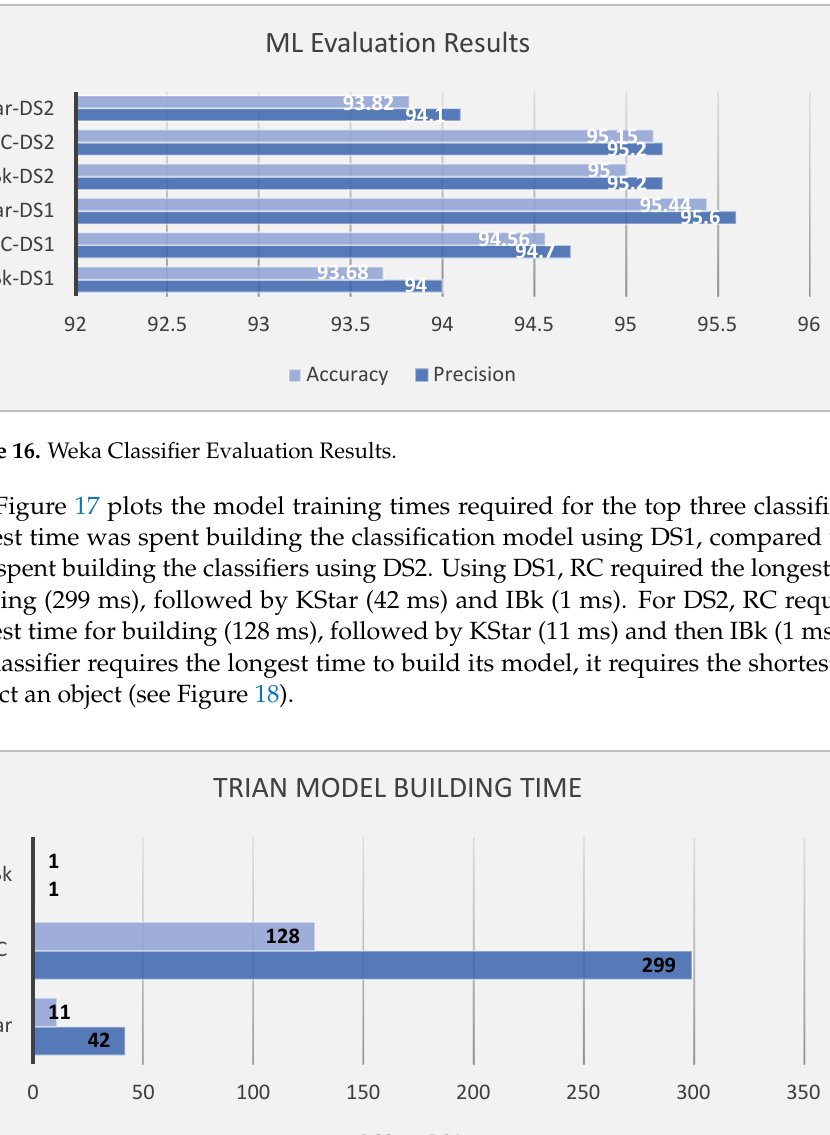
DS1 and DS2 test samples, we constructed 10 test predictions and timed each classifier in order to produce the outcome. The time required for KStar to forecast an object varied between 22 and 55 milliseconds when using the DS1 test samples and between 9 and 13 milliseconds when using the DS2 test samples. The IBk classifier, on the other hand, showed faster times than KStar, with an average of 4–5 milliseconds for the DS1 test sam- ples and 0–1 milliseconds for the DS2 test samples. Random Committee required a sub- stantial amount of time to develop its training model, and it predicted the test samples in less than 1 millisecond for both the DS1 and DS2 test samples. ( a ) ( b ) Figure 18. Classifiers’ Inference Elapsed Time in Milliseconds for ( a ) DS1 Test Samples and ( b ) DS2 Test Samples. It is worth mentioning that the IBk and KStar algorithms trained and generated mod- els faster than the Random Committee algorithm (see Figure 17). Random Committee re- quired 299 milliseconds to create its trained model using DS1, whereas for DS2 it required 128 milliseconds. KStar additionally required a long time to construct its training model, taking 42 ms for DS1 and 11 ms for DS2. On the other hand, for both DS1 and DS2,the IBk classifier built the trained model in 1 ms. As a consequence, we suggest that the IBk